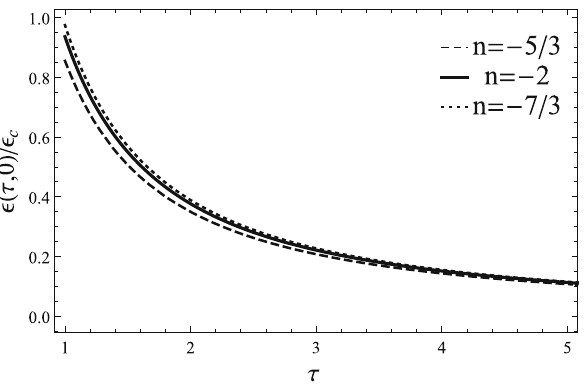
Fig. 5 Transverse velocity v(τ, x ) versus τ plotted at x = 1 with different values of n . The dashed, solid and dotted curves correspond to n = − 5 / 3 , − 2 and − 7 / 3, respectively